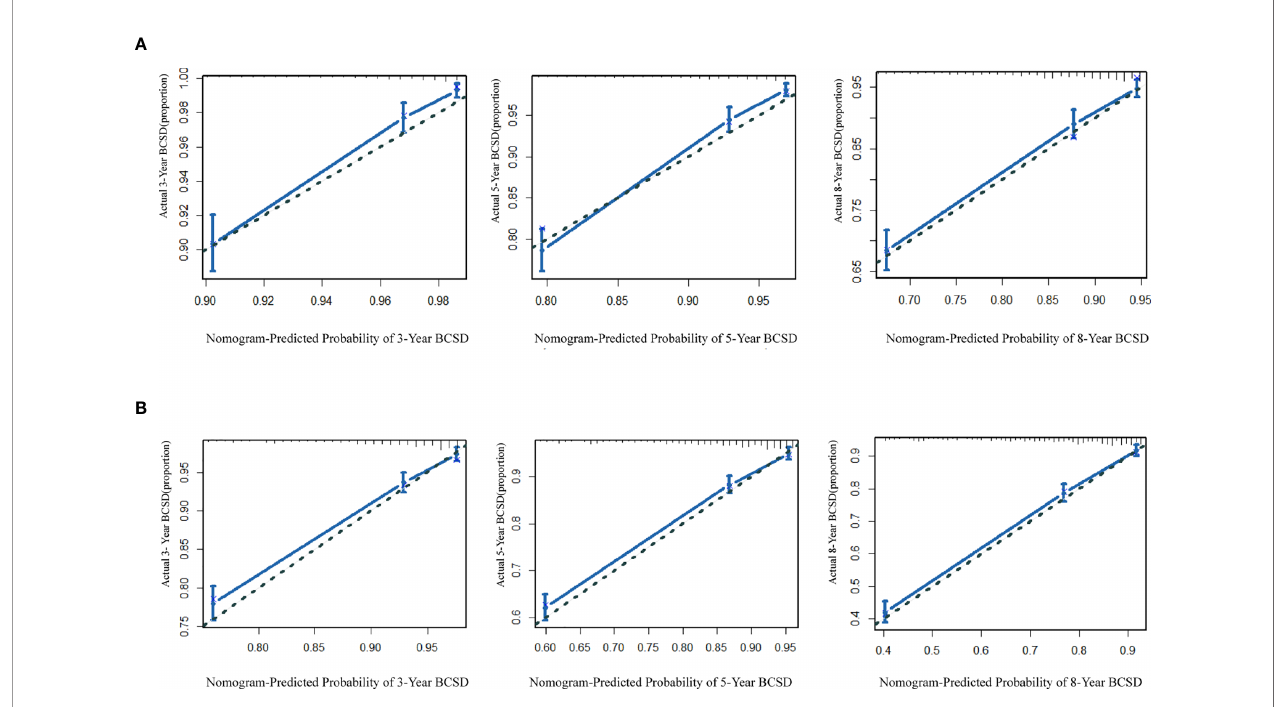
FIGURE 5 | (A) The calibration curve for predicting patient BCSD after three, fi ve, and eight years in the training cohort; (B) the calibration curve for predicting patient BCSD after three, fi ve, and eight years in the internal validation